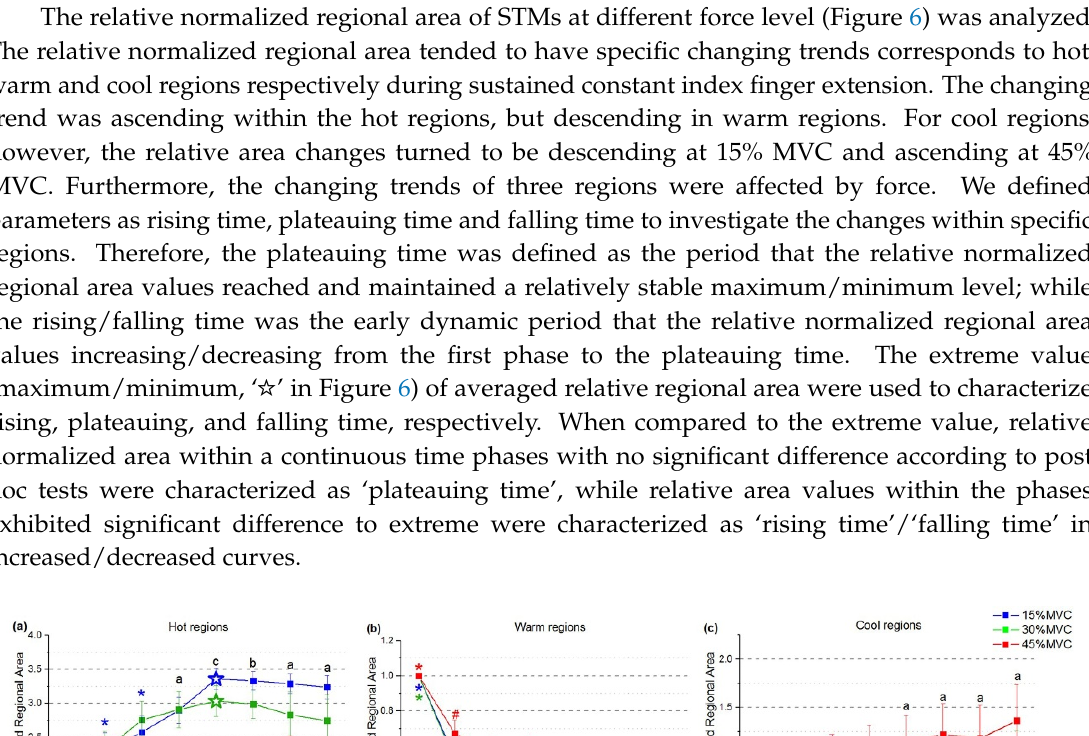
Figure 6. The relative normalized regional area of hot regions ( a ), warm regions ( b ), and cool regions ( c ) during sustain constant index finger contractions at three force levels. ‘ ☆ ’ represent the extreme values. Asterisk and octothorpe indicate significant difference compared with the extreme values (* p < 0.005; # p < 0.05). Different lowercase letters indicate significant effect among force levels (a 0.01 < p < 0.05; b 0.005<p < 0.01; c p < 0.005). For hot regions, the relative normalized regional area at three different force levels required different rising time. According to Figure 6a, the statistical results indicated that the rising time lasted from phase 1 to 3 at the force of 15% MVC (blue), but occupied the first phase only at 30% MVC (green). When performing tasks with the force level of 45% MVC, the plateau started within the first phase (red). For warm regions (Figure 6b), the relative regional areas exhibited a decreased trend at all force levels, as the ‘falling time’ of 15% (blue) and 30% MVC (green) lasted from phase 1 to 3. Contraction with 45% MVC (red) clarified a shorter falling time included the first two phases. For cool regions (Figure 6c), the trend of the relative normalized area change showed distinct differences according to force levels. At 15% MVC (blue), the relative area declined during the first three time phases and then reached the plateau, while plateauing time at 30% (green) and 45% MVC (red) lasted across all time phases. These results indicated that, the relative normalized regional areas according to the three regions (hot, warm, and cool) took a longer variation course (rising/falling time) at lower force level (15% and 30% MVC), whereas they kept relatively stable at 45% MVC from the beginning of contraction.